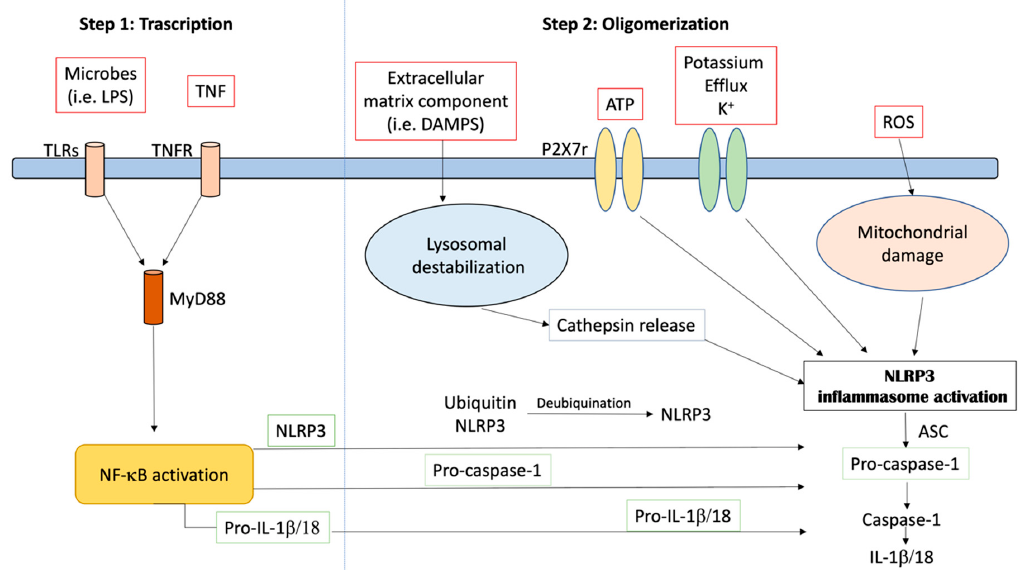
Figure 1. Activation of the NLRP3 inflammasome.